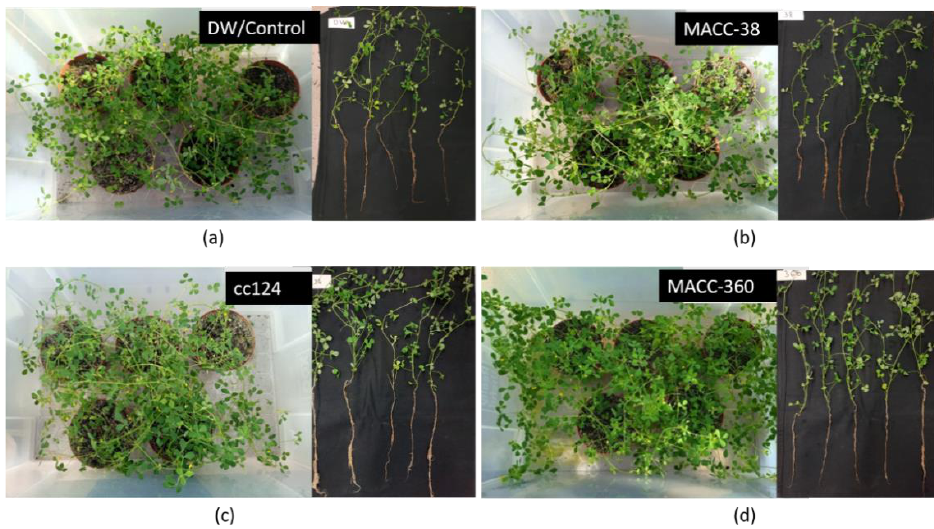
Figure 4. Aerial pictures of the plants (five pots per treatment placed in a box) at 45 days after planting: ( a ) DW/Control plants; ( b ) Chlorella MACC-38-treated plants; ( c ) C. reinhardtii cc124-treated plants and ( d ) Chlorella MACC-360-treated plants. For all figure panels, the left image shows the aerial view, while the right one shows the front view of uprooted plants.